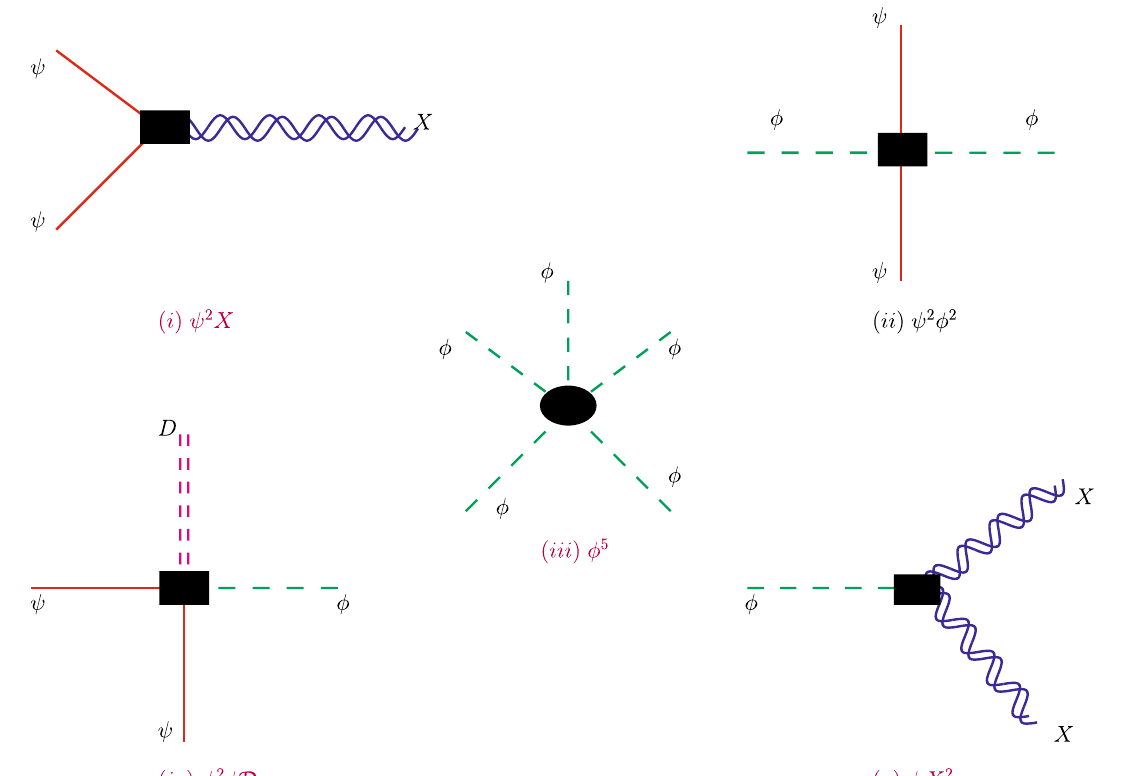
Fig. 2 Diagrammatic representation of mass dimension-5 (for 3 + 1 space-timedimensions)operatorclassesconstitutedbycombiningspin- 0 ( φ ), spin-1/2 ( ψ ) and Field Strength Tensor ( X ) of spin-1 fields and the covariant derivative ( D ). Only one of these (diagram ( ii ) ) appears